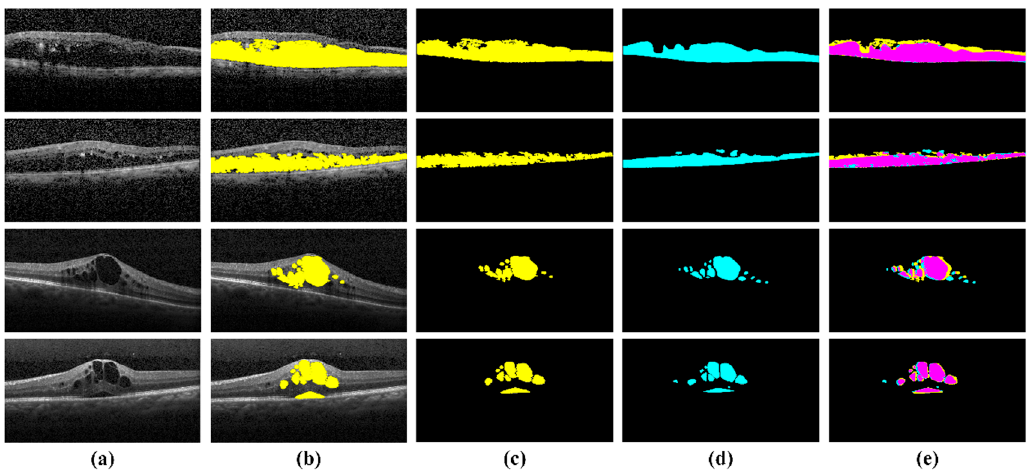
Figure 12. Extracted retinal fluid regions in the [35,36] datasets. ( a ) Original OCT scans; ( b ) overlaid retinal fluid regions on original OCT scans; ( c ) extracted retinal fluid regions through the proposed system; ( d ) local clinician markings of retinal fluid regions ( e ) retinal fluid extraction against expert markings—cyan represents the expert markings of local clinician, yellow represents the retinal fluid regions extracted through the proposed system and magenta represents the overlapped region of retinal fluids.